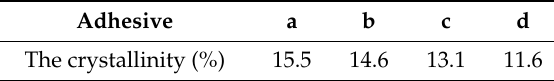
Table 4. The crystallinity of different cured adhesives: ( a ) SF adhesive; ( b ) SF/LB adhesive; ( c ) SF/PAE adhesive; and ( d ) SF/LB/PAE